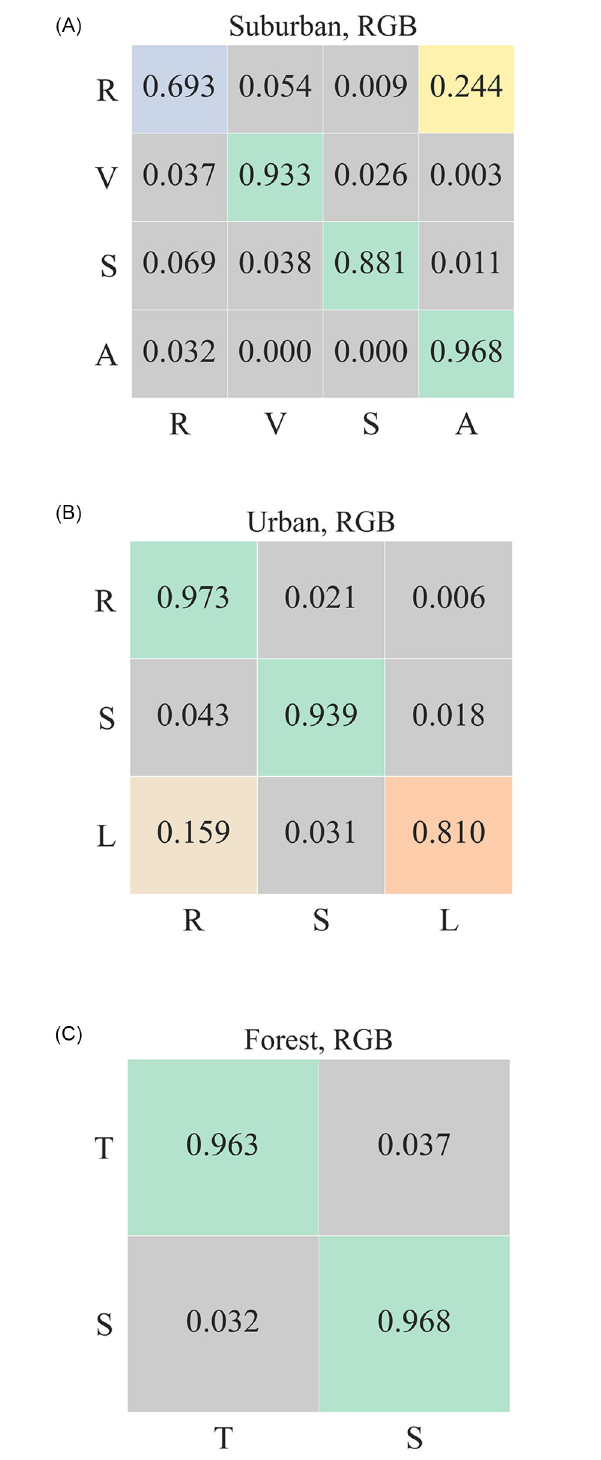
Fig 5. Confusion matrix for classification scores for three datasets using RGB data. (Left) R, V, S, and A refer to Rooftop, Vegetation, Shadow, and Asphalt; (Center) R, S, L refer to Rooftop, Shadow and Lawn, respectively; and (Right) T, S refer to Tree and Shadow,